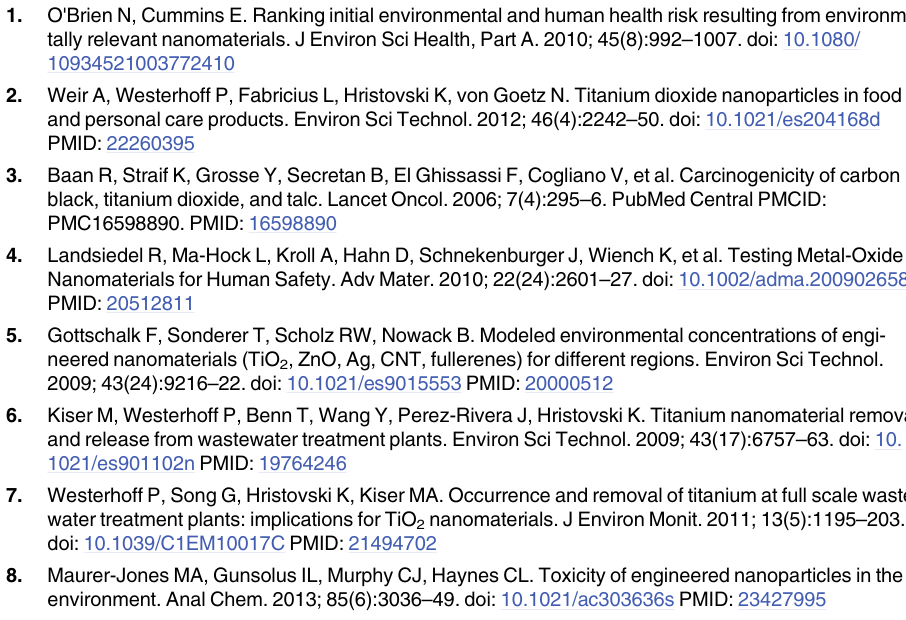
S4 Fig. EDX analysis of the biofilm from the consortium: EDX analysis depicting presence of elemental titanium in the